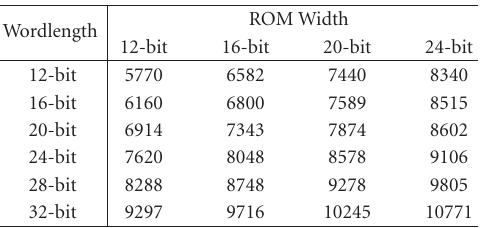
Figure 8: System architecture of the cochleagram display. Table 2: Area requirements of an 88-section cochlea implementa- tion of di ff erent wordlengths and ROM width (number of slices).